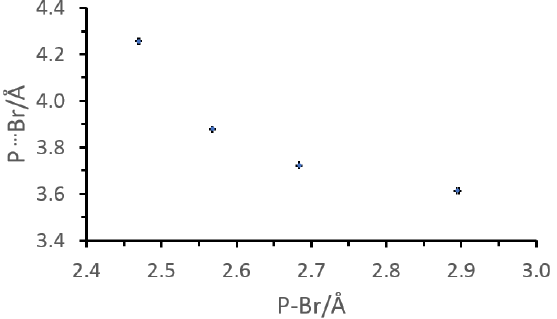
Figure 2. Plot of intramolecular (P–Br) vs. intermolecular (P · · · Br) distances in crystalline 2c – f . Table 1. Selected intramolecular distances (in Å ) for 2c - f , 3a , 4 , 5 . X